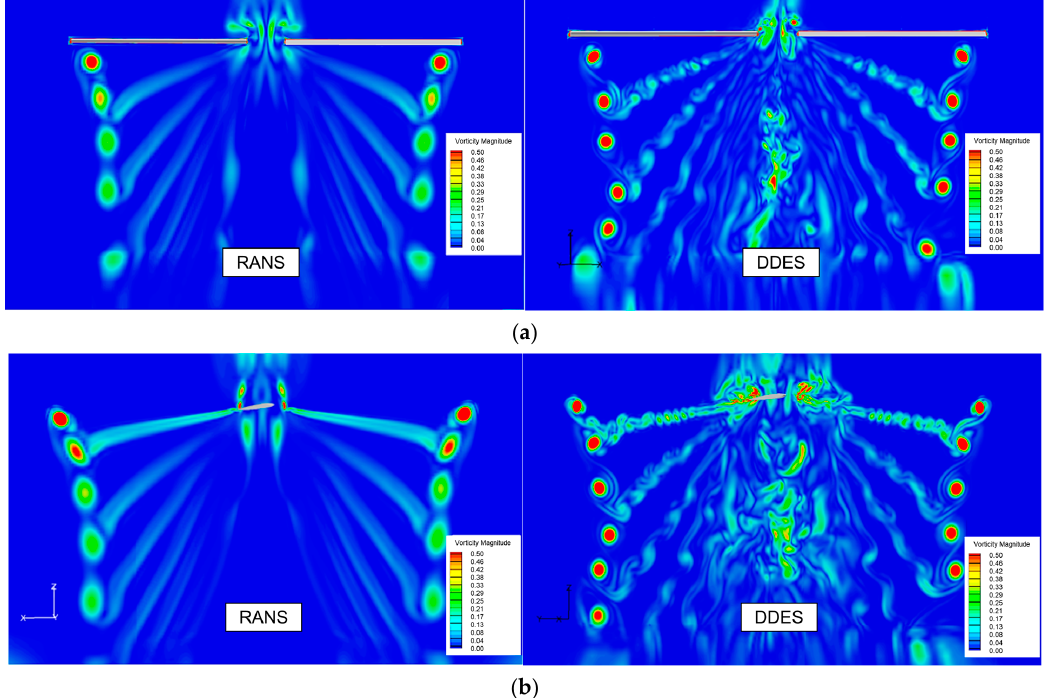
Figure 16. Comparison of cross-section vorticity distribution obtained by RANS and DDES. ( a ) Y = 0 section, ( b ) X = 0 section.